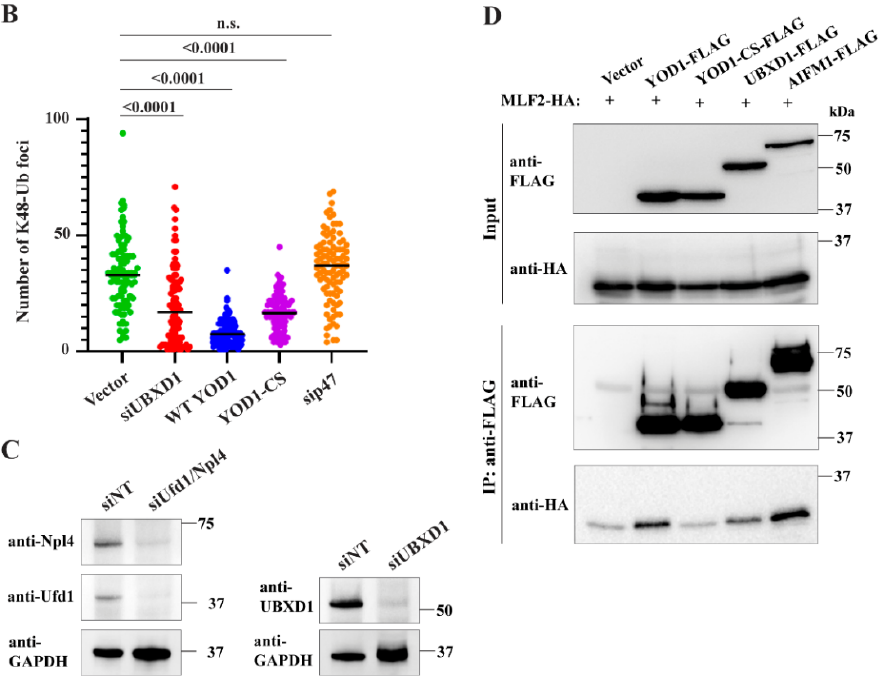
Figure 3. p97 depends on the cofactors YOD1 and UBXD1 to generate the K48-ubiquinated proteins sequestered inside blebs. ( A ) Representative IF images of TorsinKO cells overexpressing MLF2-HA under conditions of normal or disrupted p97 activity. p97 activity was disrupted by knocking down UBXD1 or p47 or overexpressing the dominant-negative YOD1-CS-FLAG. UBXD1 and p47 were knocked down for 48 h and overexpressed constructs were overexpressed for 24 h prior to processing for IF. Cells were stained with antibodies against K48-Ub and HA. Note that WT YOD1-FLAG is an active deubiquitinase (DUB) that cleaves the K48-Ub chains off clients that are normally ubiquitylated and sequestered into blebs. Scale bar, 5 µ m. ( B ) The number of K48-Ub foci was quantified for 100 TorsinKO cells/condition. Statistical analysis was performed using a Mann–Whitney U test. N.s., not significant. ( C ) An immunoblot confirming the effects of siRNA targeting Ufd1, Npl4, or UBXD1 in TorsinKO cells after 48 h of knockdown. ( D ) An IP of FLAG ‐ tagged WT YOD1, YOD1 ‐ CS, UBXD1, or AIMF1 from TorsinKO cells expressing MLF2 ‐ HA. Cells were allowed to express the constructs for 24 h prior to harvesting. An IP of the FLAG tag for all samples was analyzed by immunoblot against the FLAG and HA tags. MLF2 ‐ HA specifically co ‐ immunoprecipitates with WT YOD1, UBXD1, and AIFM1.